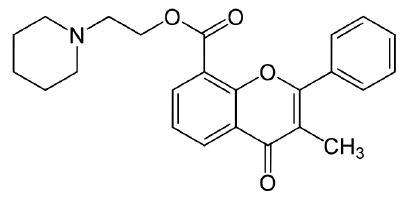
Figure 2. Flavoxate, FDA-approved drug.